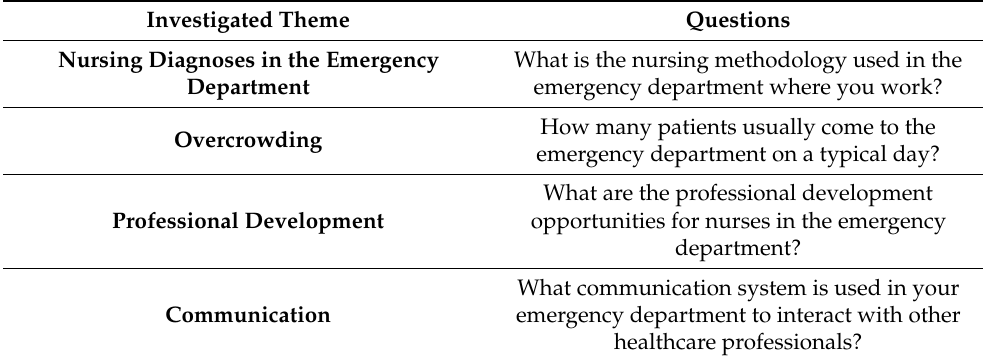
Table 2. Unstructured in-depth interview